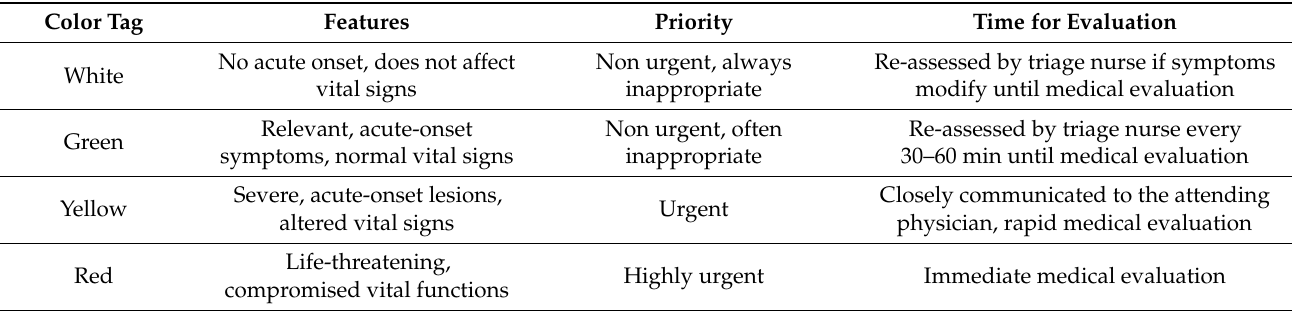
Table 1. Triage color code system (Montefiori M, Di Bella E, Leporatti L, Petralia P. Robustness and Effectiveness of the Triage System in the Pediatric Context. Appl Health Econ Health Policy 2017; 15: